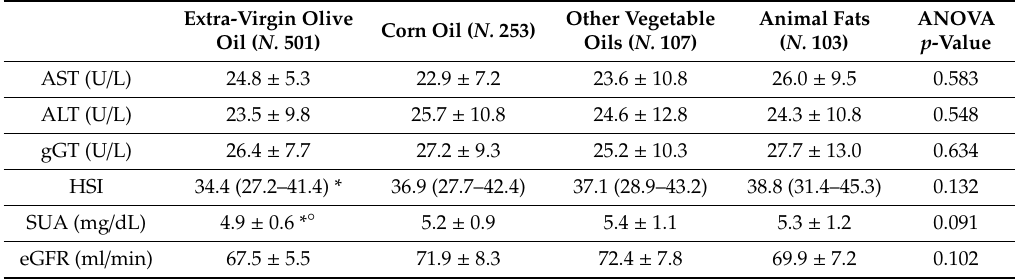
Table 5. Liver and renal characteristics of subjects predominantly consuming di ff erent cooking fats in everyday